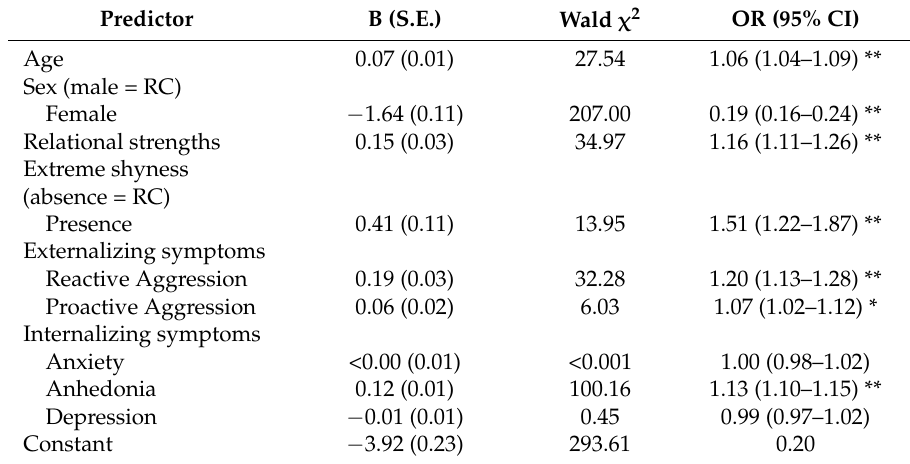
Table 3. Regression analysis: Problematic video gaming (PVG) as the dependent variable and facets of internalizing and externalizing symptoms as